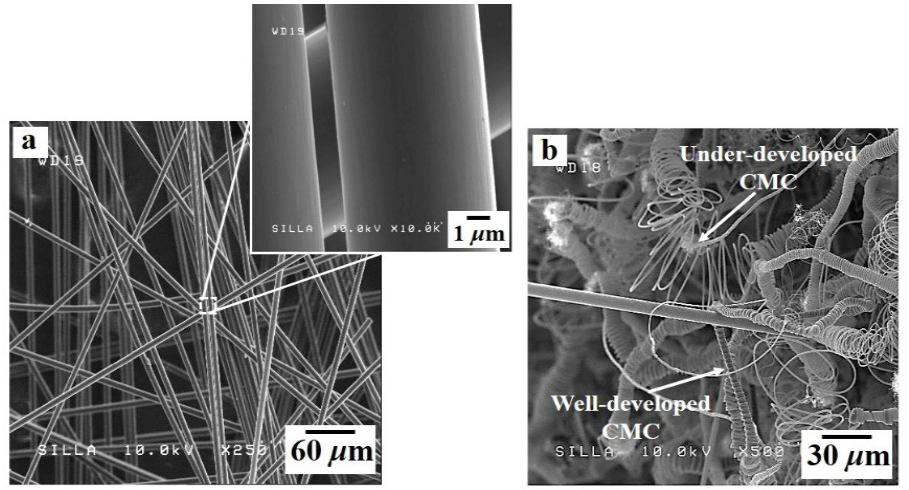
Figure 3. FESEM images of ( a ) sample A and ( b ) sample B. The inset in Figure 3a shows the very clean surfaces of the i-CFs.